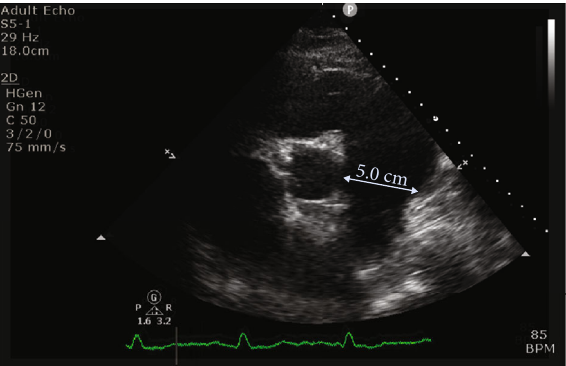
Figure 2: Transthoracic echocardiogram demonstrating signi fi cant dilatation of the main pulmonary artery (diameter: